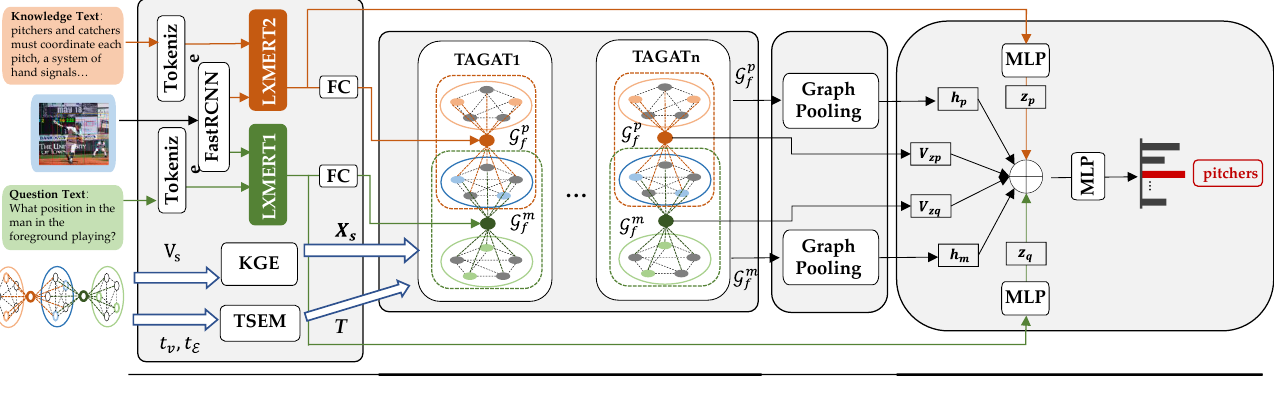
Figure 4. The overarching architecture of the MSG-KRM.